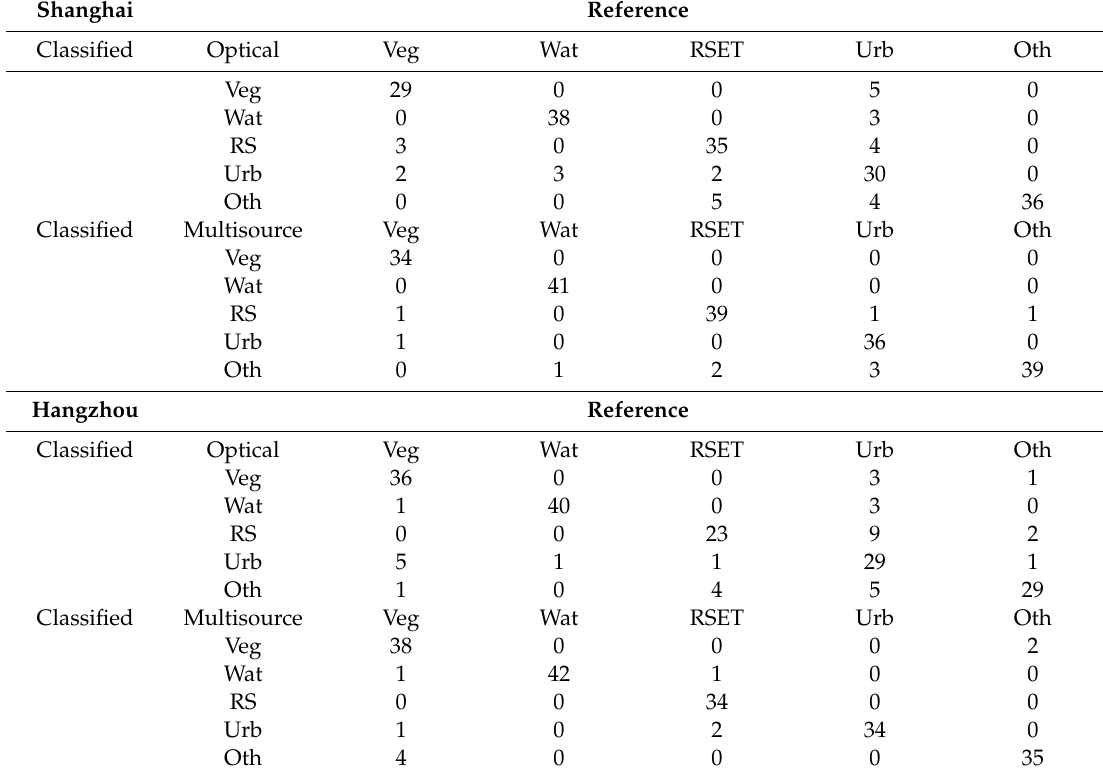
Table 4. Confusion matrix of optical (O) and multi-source (MS) results in Shanghai and Hangzhou.